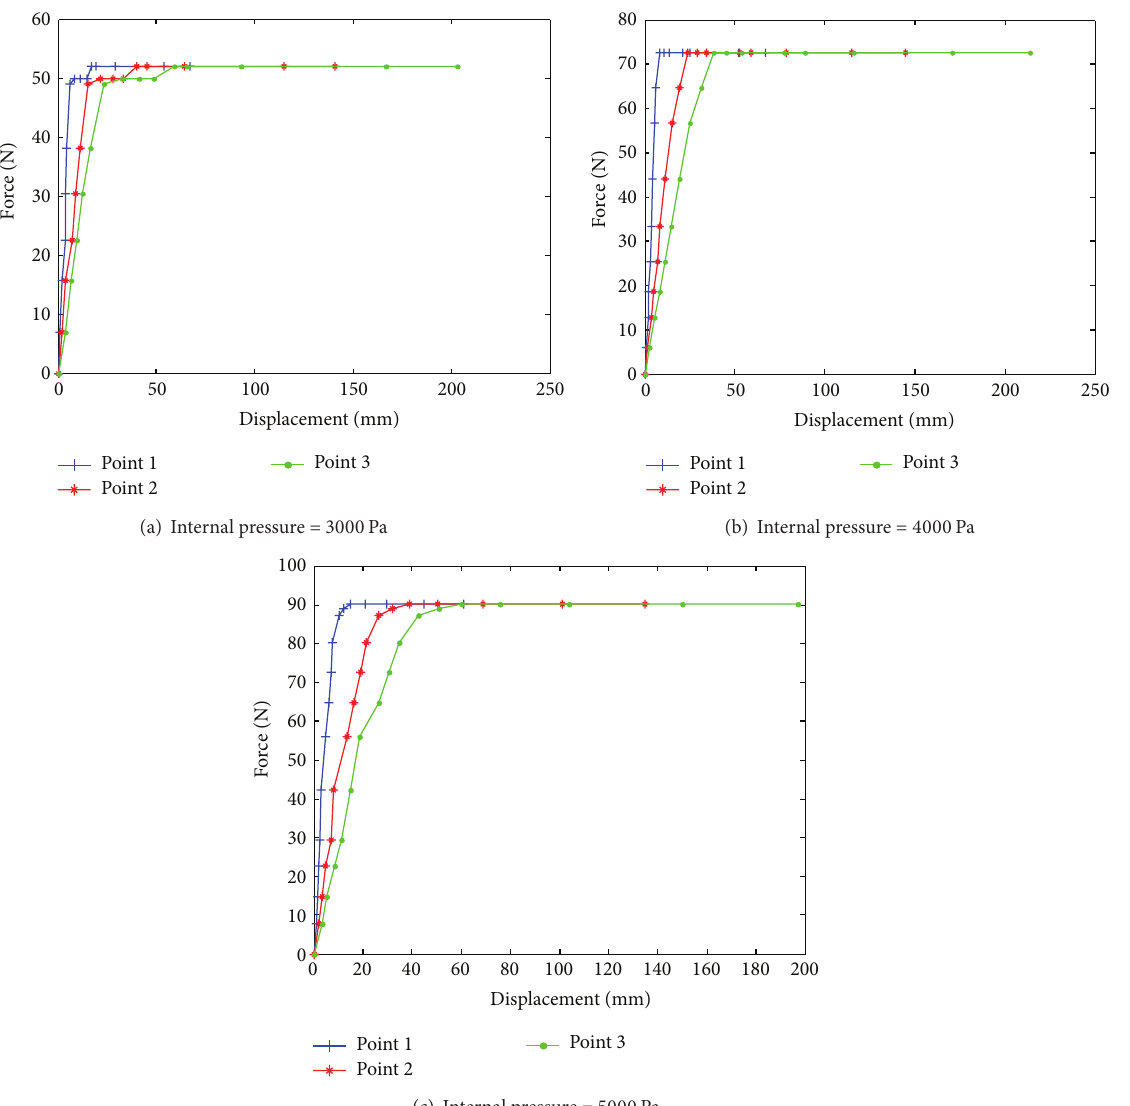
Figure 4: Experimental load-deflection behavior of the ETFE inflatable